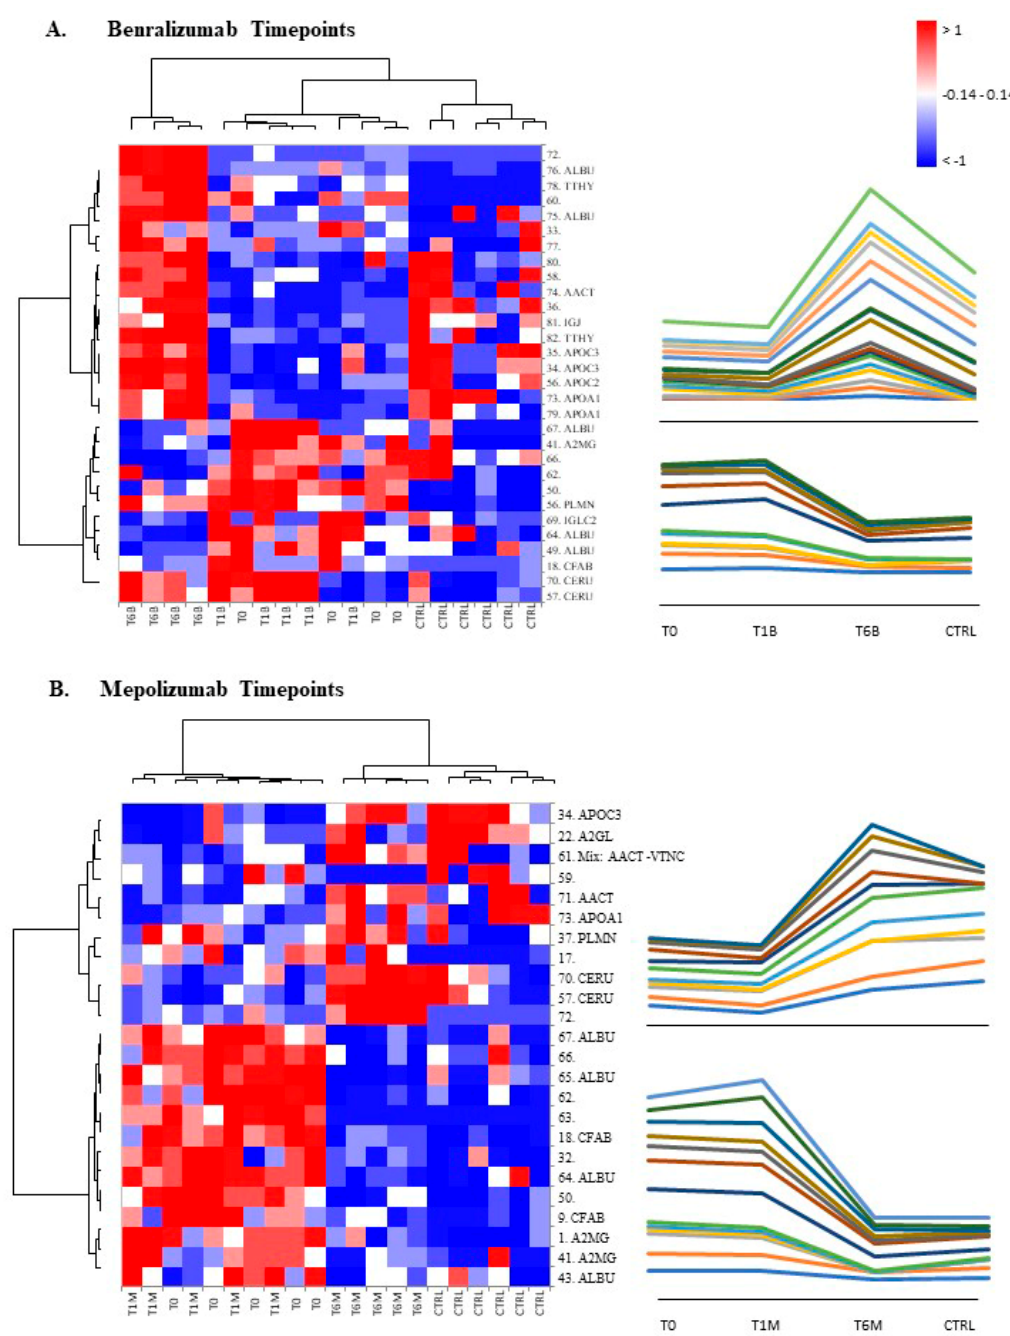
Figure 3. Heatmap analysis performed on significant matched spots in benralizumab time points analysis ( A ) and mepolizumab time points analysis ( B ). On the right, the line charts show the trend of abundance of the clustered spots.